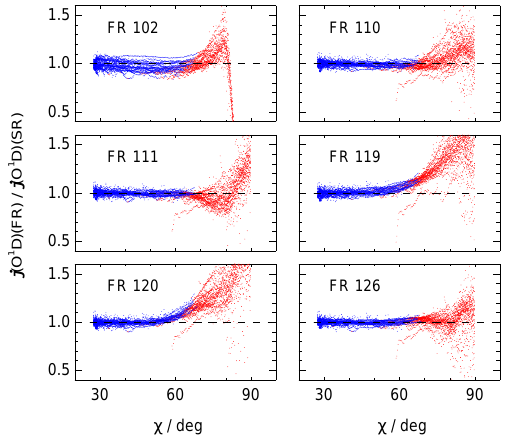
Figure 9. Reproduction of a part of Fig. 15 from Bohn et al. (2008) with the j (O 1 D) filter radiometer results of the ACCENT compari- son. The ratios of j (O 1 D) from the filter radiometers and the spec- troradiometer reference were plotted as a function of solar zenith angles after application of correction factors f by the participants and of calibration factors A 0 from the comparison. Red data points indicate values below 10% of maximum values (2 . 8 × 10 − 5 s − 1 ). Measurement period: 1–12 June 2005.